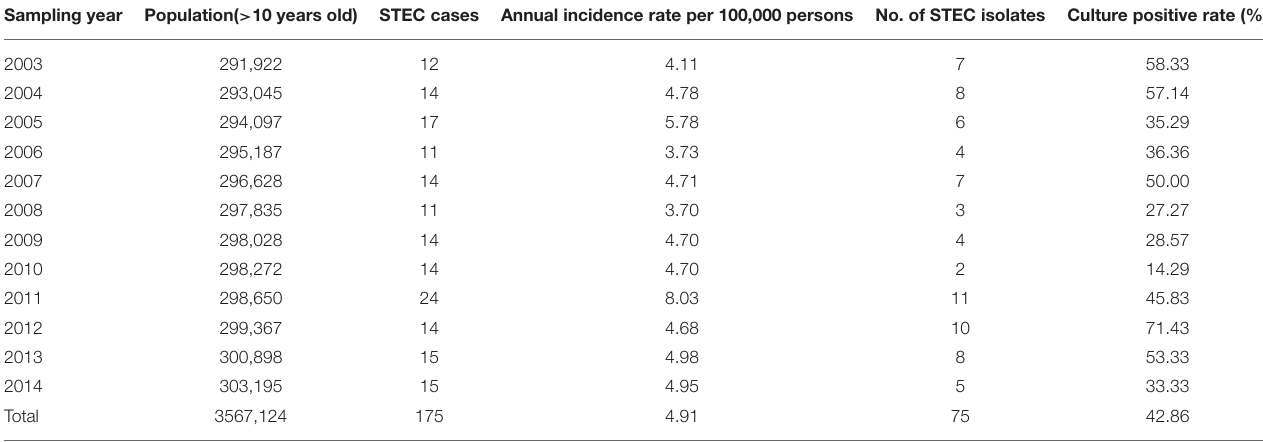
TABLE 1 | STEC incidence in adults over 10 years of age from April 2003 to January 2015, Jönköping county, Sweden.